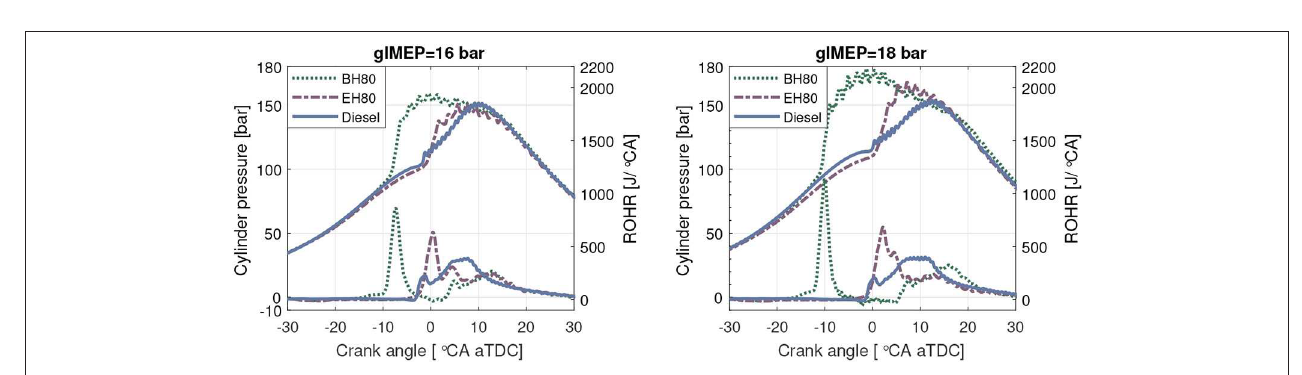
FIGURE 9 | Cylinder-pressure and ROHR at 16 and 18 bar